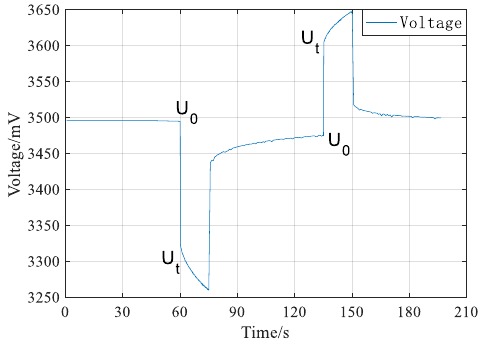
Figure 8. The 80% SOC HPPC test process.